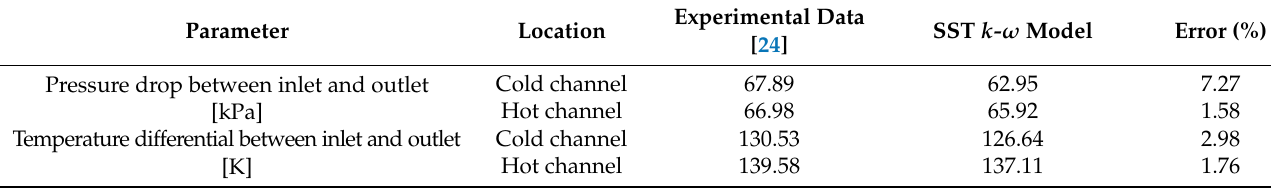
Table 5. Experimental and numerical results of PCHE models.